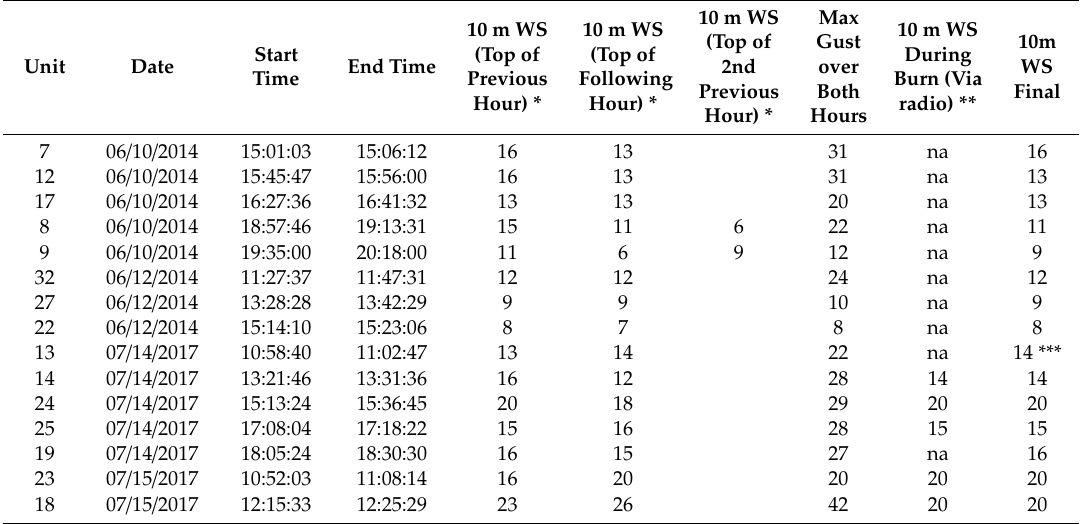
Table A1. Summary of wind observations for the burning window at the Paquette Lake